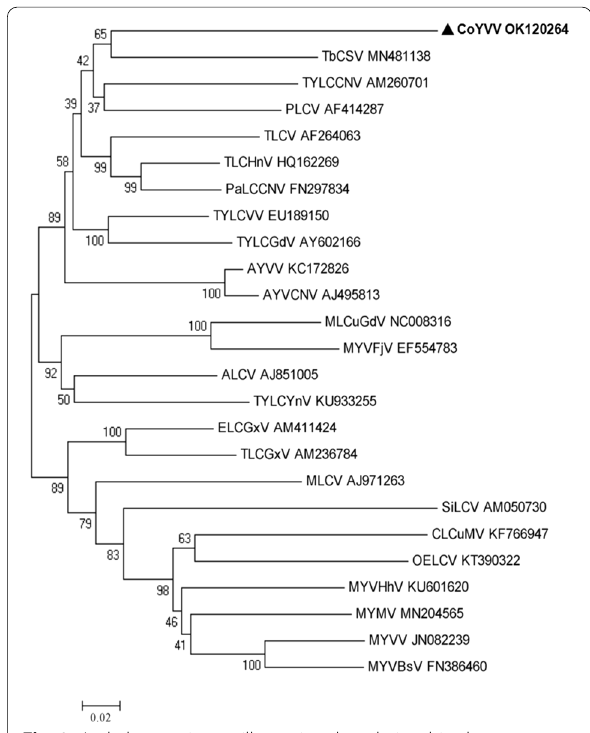
Fig. 2 A phylogenetic tree illustrating the relationships between CoYVV and other previously reported begomoviruses. The neighbor-joining phylogenetic tree was generated in MEGA5.0 using the maximum-likelihood method with 1000 bootstrap replications